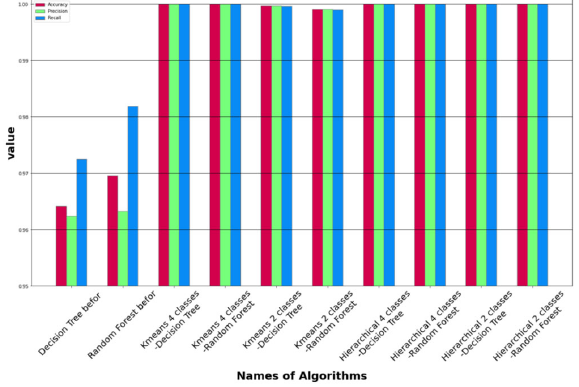
Fig. 18. The accuracy comparison in the first and second phases after the feature selection